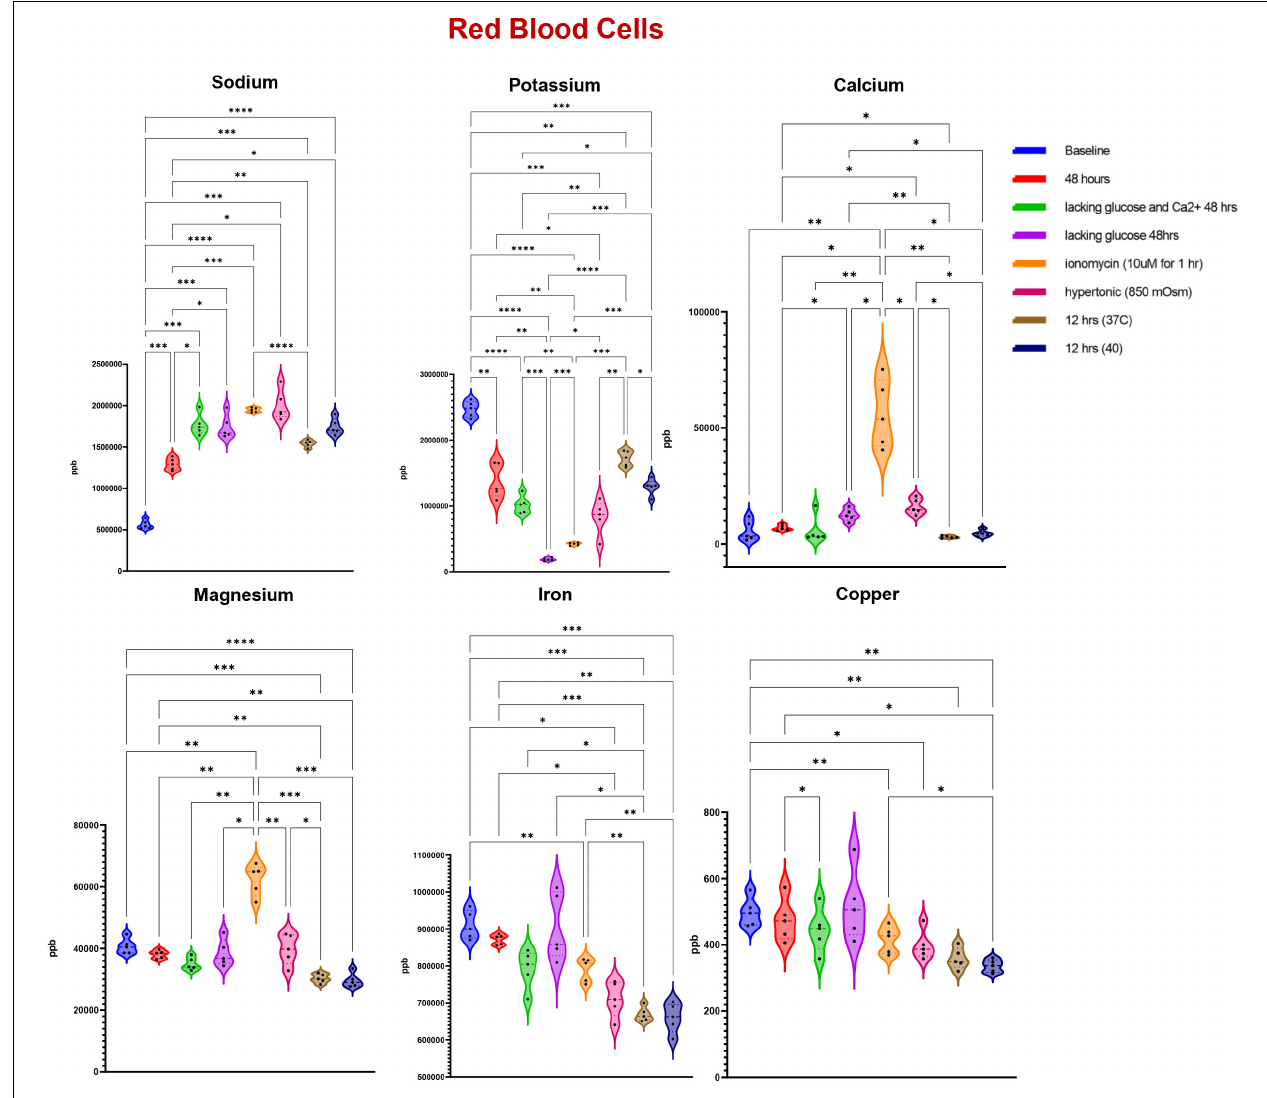
FIGURE 1 | Measurements of trace elements in red blood cells exposed to starvation (glucose or glucose and calcium), ionic (ionomycin or hypertonic saline), or heat stress (40 vs. 37 ◦ C). Significance was determine via ANOVA with Tukey’s multiple comparison test ( ∗ p < 0.05; ∗∗ p < 0.01; ∗∗∗ p < 0.001; ∗∗∗∗ p <